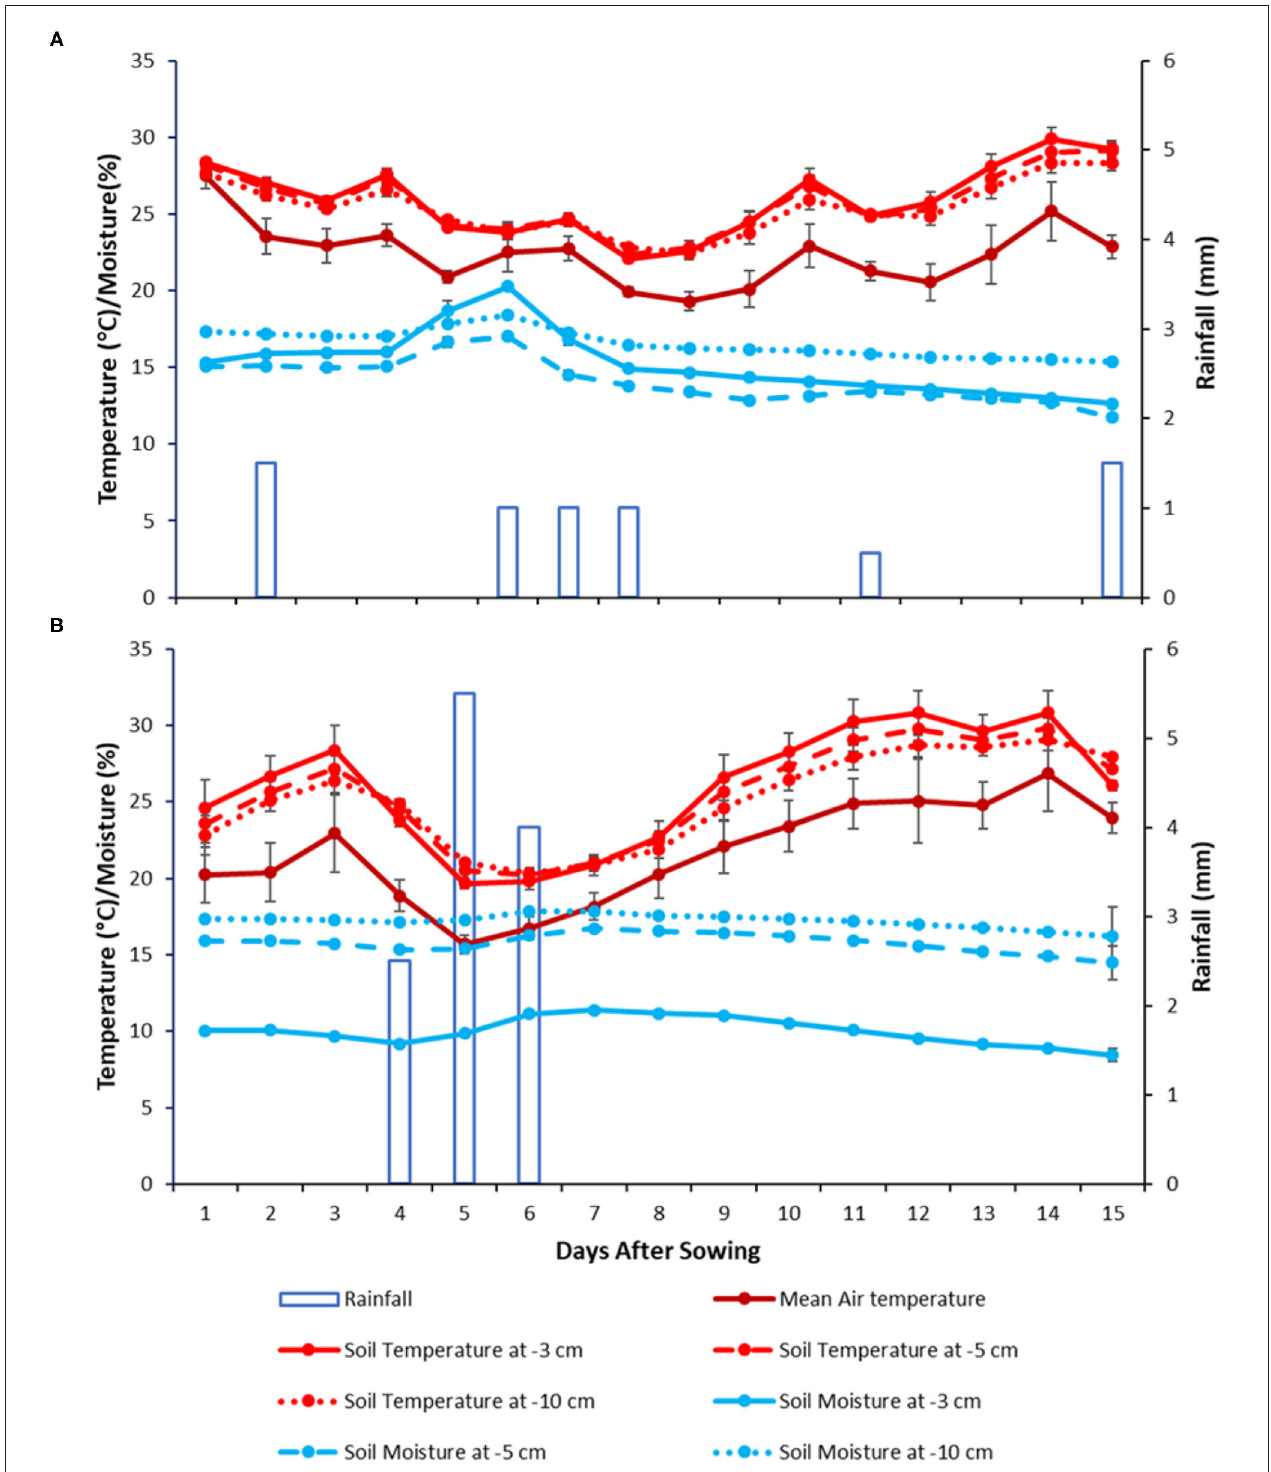
FIGURE 1 | Sowing depth temperature, moisture, and rainfall from sowing until emergence of hybrid oilseed varieties of sunflower in 2020 (A) , and 2021 (B) at the Auzeville experimental station. Vertical bars reported in the figures represent confidence intervals. (mean 25 ± 2 ◦ C) in 2021 ( Figure 1B ). The temperatures at 5 while the gravimetric moisture was higher with the increasing and 10 cm depth were very similar to that at the sowing depth sowing